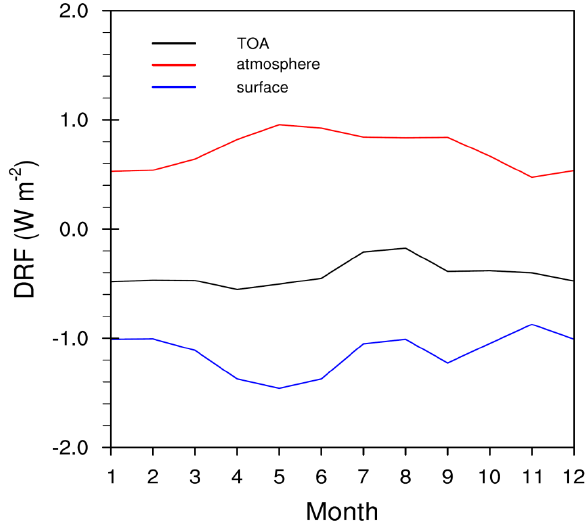
Fig. 10. Monthly mean anthropogenic aerosol DRF at TOA, atmo- sphere and surface for all sky. Unit: Wm − 2